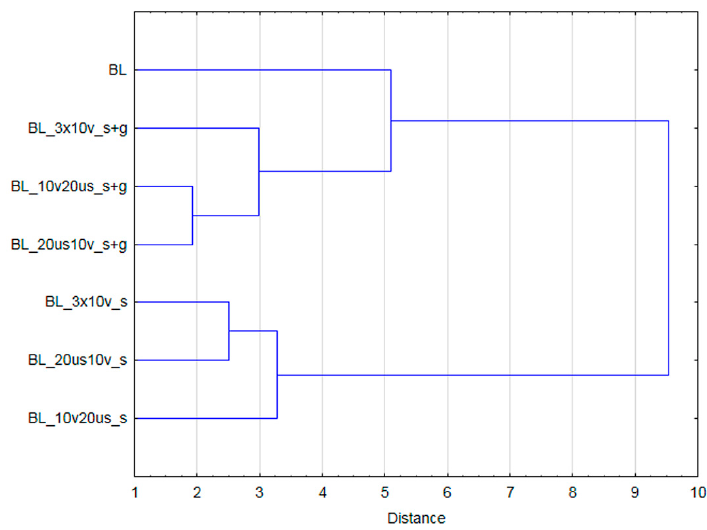
Figure 6. The results of cluster analysis (considering all analyzed variables) for samples not subjected to osmotic dehydration (BL - blanched material). Foods 2019 , 8 , x FOR PEER REVIEW